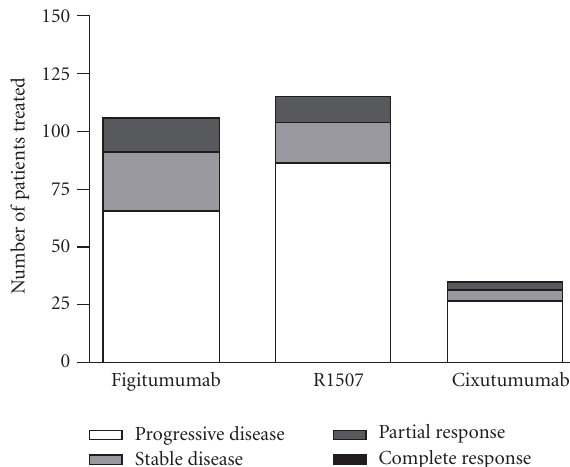
F 6: Clinical results of anti-IGF-1R therapy: response to ther- apy in phase II trials for Figitumumab, R1507, and